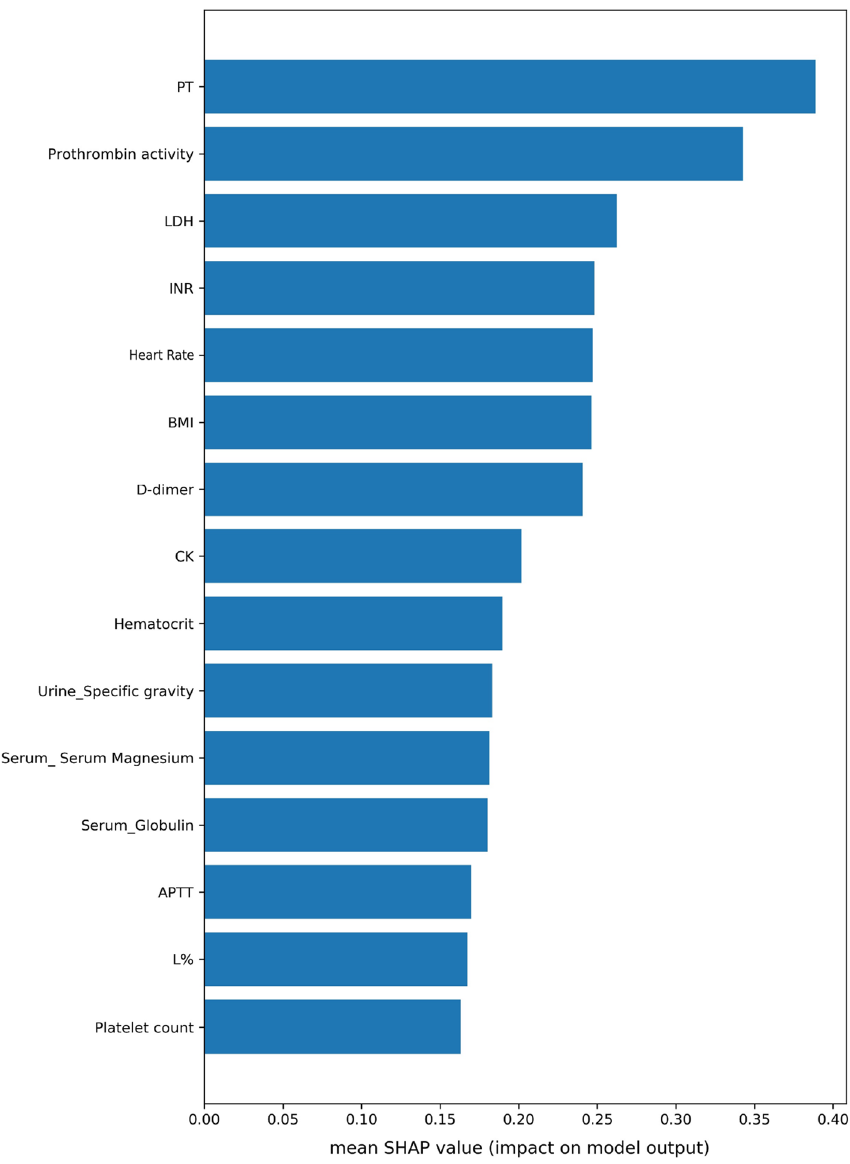
Figure 2. Importance rankings according to the mean absolute SHAP value. Abbreviations are as follows. PT: Prothrombin time, LDH: lactate dehydrogenase, INR: international normalized ratio, DD: D-dimer, CK: creatine kinase, APTT: activated partial thromboplastin time, L: lymphocyte count, SHAP: Shapley additive